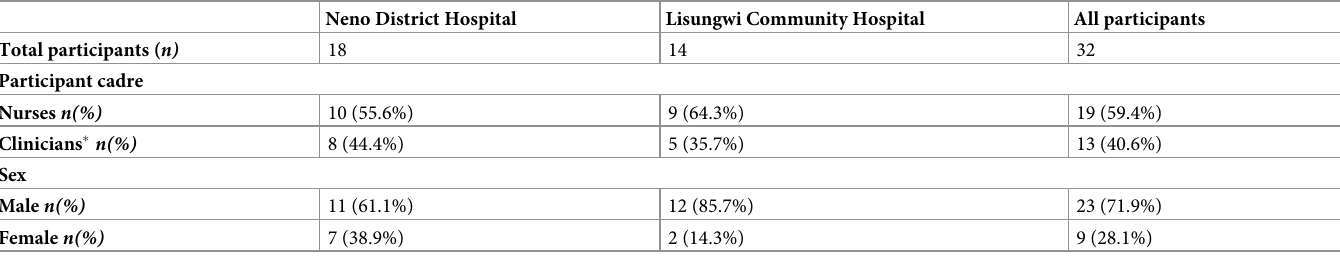
Table 1. Participant characteristics.